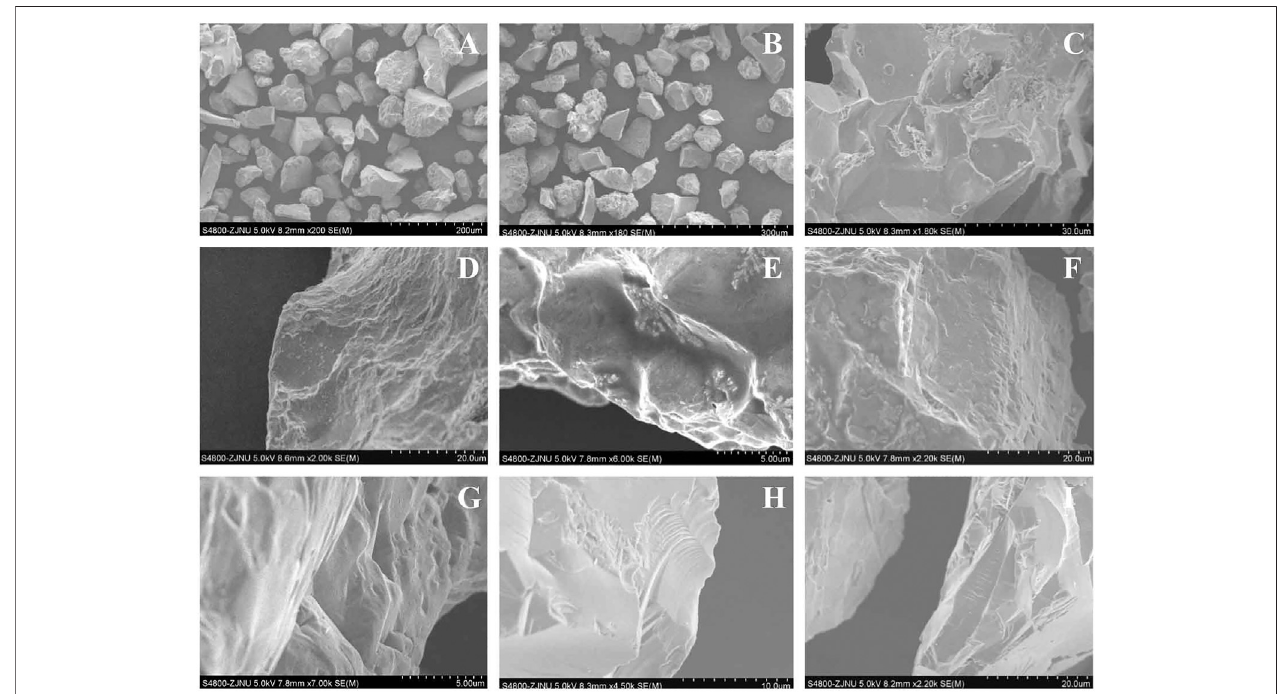
FIGURE 6 | (A – B) . Quartz grains in XG pro fi le. (C) . Collision dish-shaped depressions are common on the surface. (D) . Elongated dish-shaped depressions, meandering ridges, upturned plates and pockmarked surfaces. (E) Elongated dish-shaped depressions and crescentic marks. (F) . Crescentic marks, dish-shaped depressions and pockmarked surfaces. (G) . V-shaped cracks. (H) . Conchoidal fractures, triangular cracks and underwater polished surfaces. (I) . Grooves and V-shaped